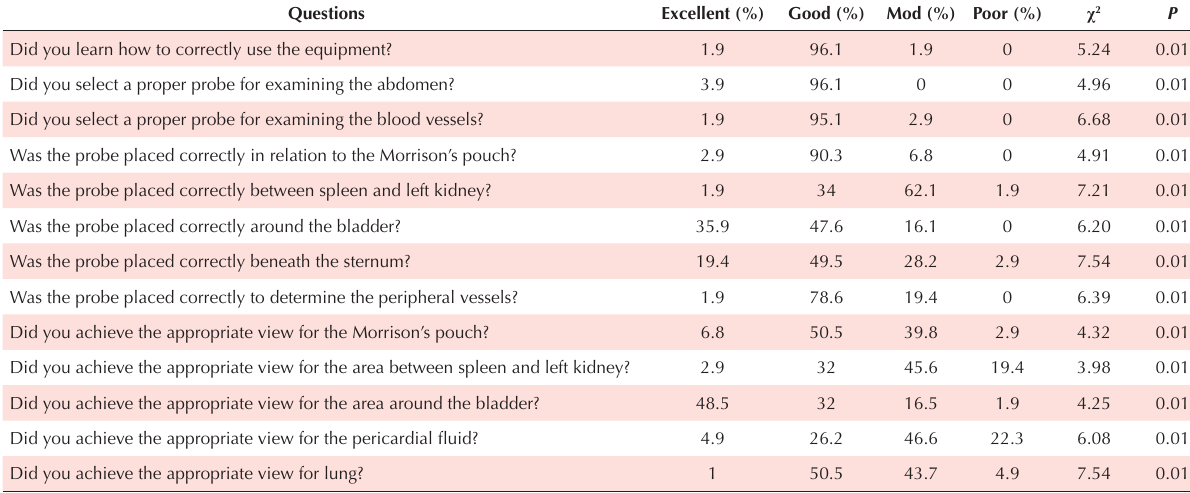
Table 2. Comparison of pre and post –test results in the detection of negative and positive images separately in the two groups Group Test n Percentage of correct response (pre-test) Kashan EMTs Percentage of correct response (pre-test) Tehran EMT s